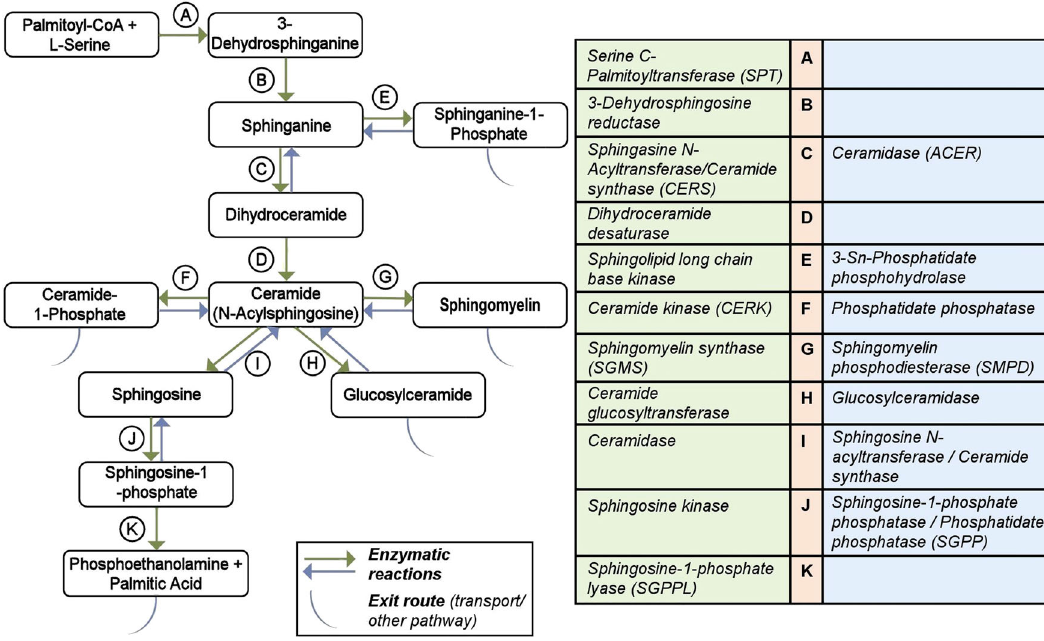
Fig. 1 Overview of sphingolipid pathway manually curated from the Recon3D model. The metabolites participating in reactions are represented in boxes. The arrows for reactions A – K are colored based on the direction in the pathway. Some reactions are not reversible (single arrows). The table on the right lists the catalyzing enzymes in the sphingolipid pathway in humans and is denoted with the same color code as the reaction